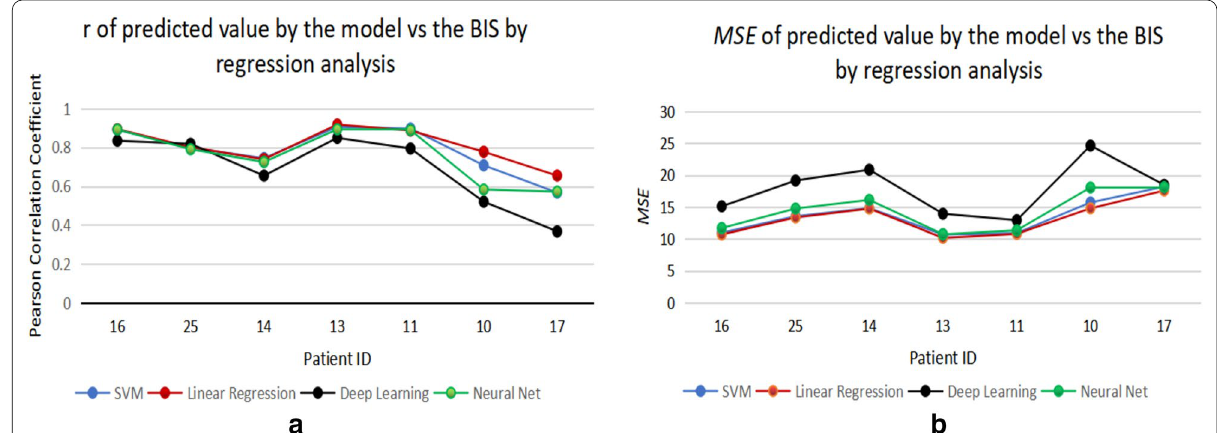
Table 2 The average execution time of regression analysis (simulated by RapidMiner version 9.4)